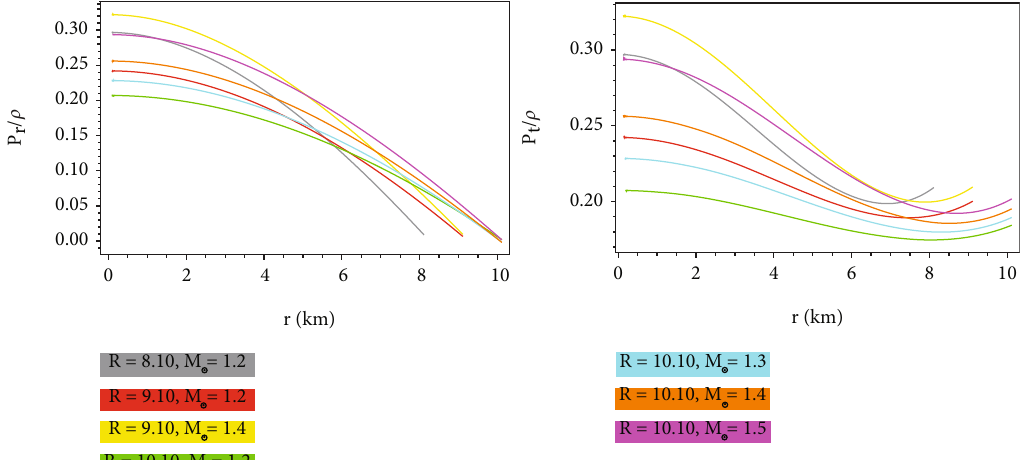
Figure 8: Evolution of w